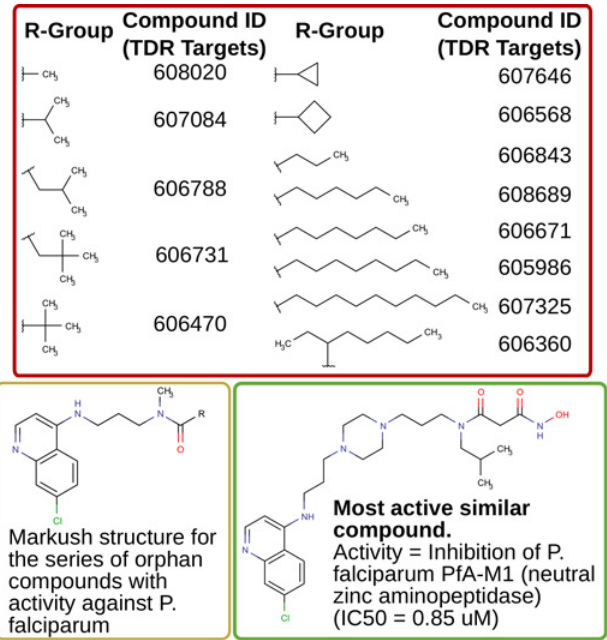
Fig 7. Suggesting targets for orphan compounds: alanyl aminopeptidase. A series of 13 structurally related orphan compounds (EC50 values range = 0.03 – 0.74 uM against P . falciparum , data from [50], available at TDR Targets) are connected in our network model to the PfA-M1 Plasmodium enzyme. In the figure we show the Markush structure for the series, and the corresponding R-groups and their database IDs. We also show one representative of other active similar compounds (see [95]) with activity against defined targets in the network.